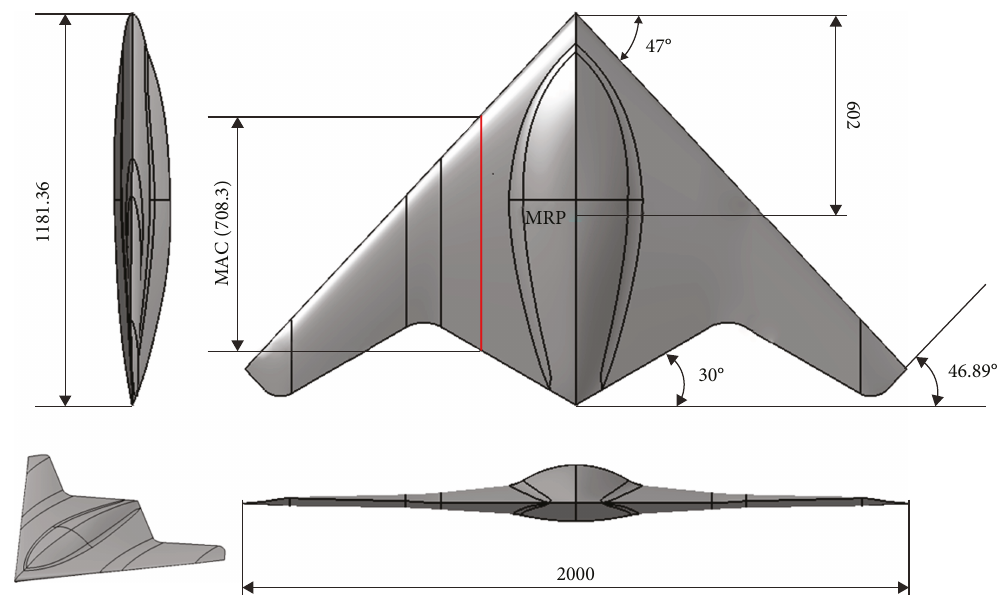
Figure 1: BWB-type planform and geometric